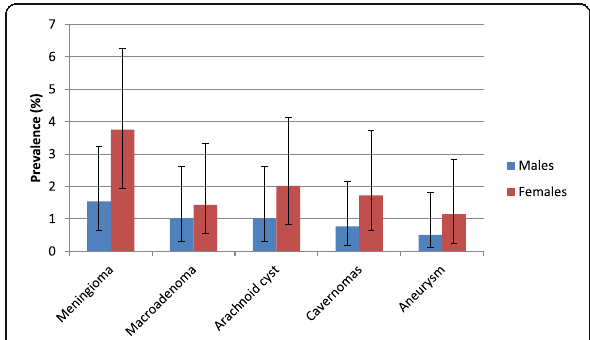
Fig. 3 Graph bar showing the male to female ratio of the most commonly detected